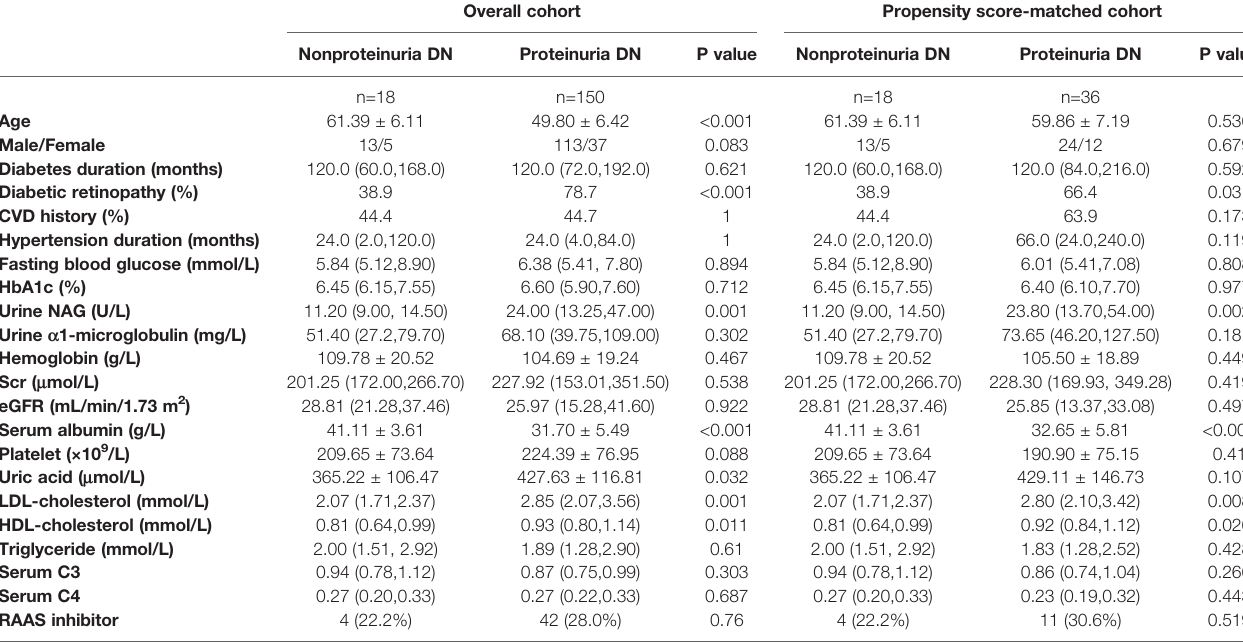
TABLE 2 | Clinical features of patients strati fi ed by proteinuria. Overall cohort Propensity score-matched